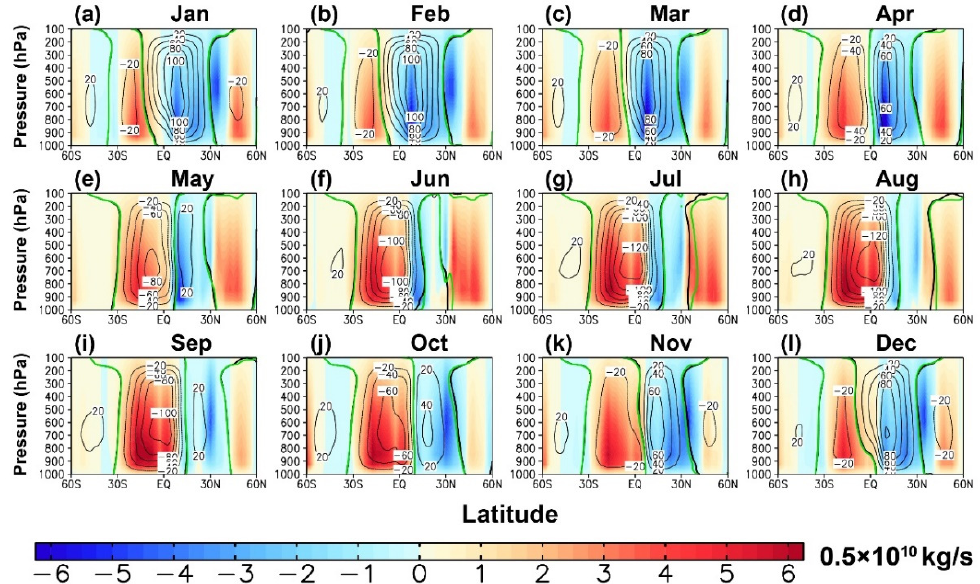
Figure 3. Black contours: mean state (1979–2018) of the HC between 60°S and 60°N represented by the MSF that considers FBGMW derived from M1 using the MRM data sets. Shading: difference between the uncorrected and corrected mean state of the HC. Green contours: same as black contours but for the zero lines of the MSF without considering FBGMW. ( a – l ) The results from January to December. The units for the MSF are 0.5 × 10 10 kg /